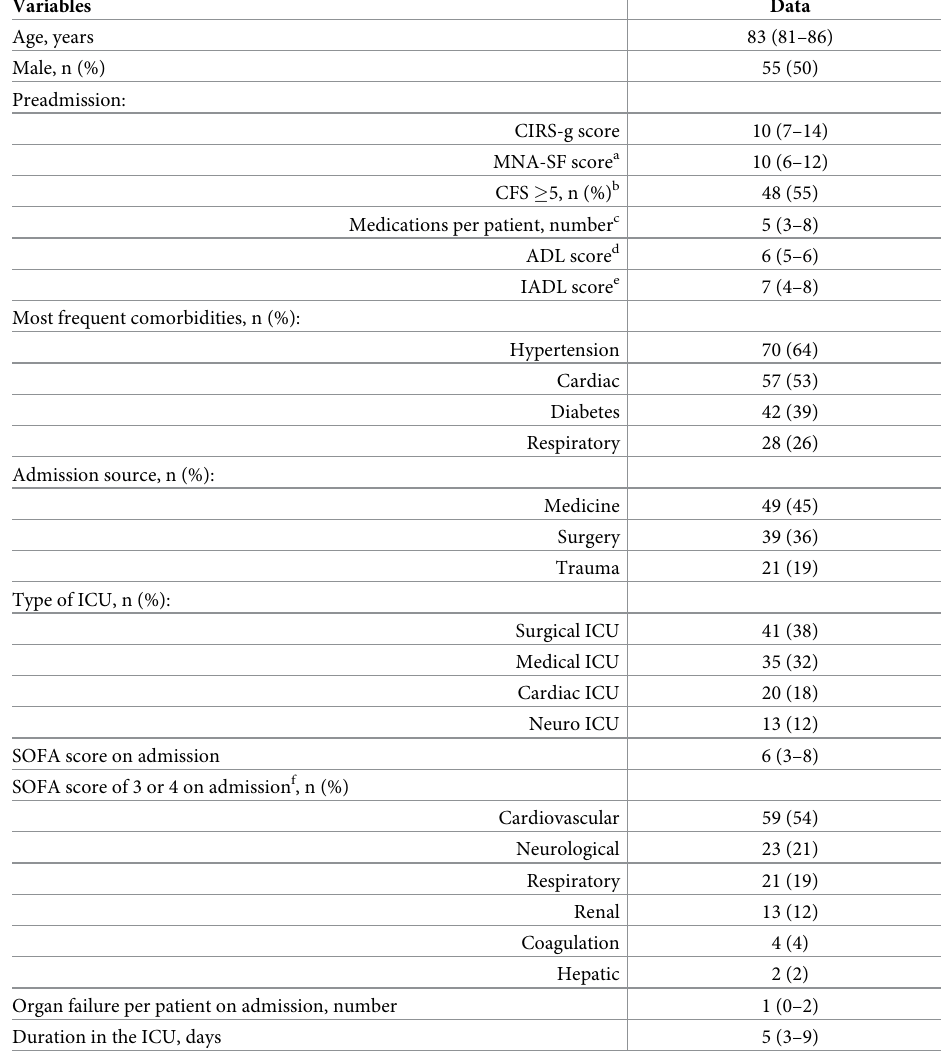
Table 1. Baseline characteristics of patients (n = 109). Data are expressed as median (25–75 th percentiles) or number (%). Variables